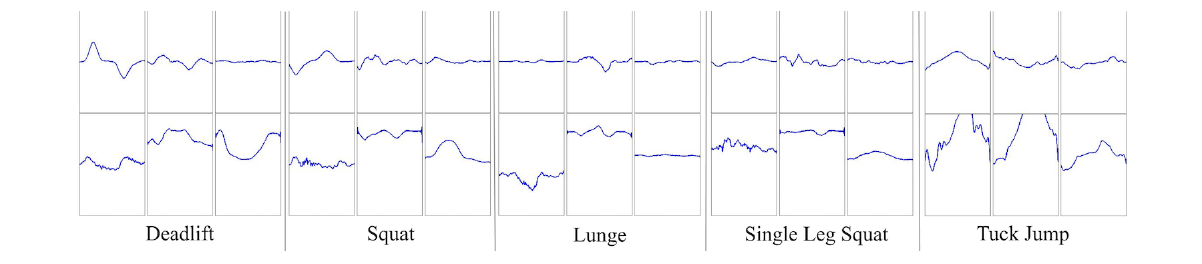
Figure 6. Samples of the generated plots (JPEG files) which were used as training and test data in this